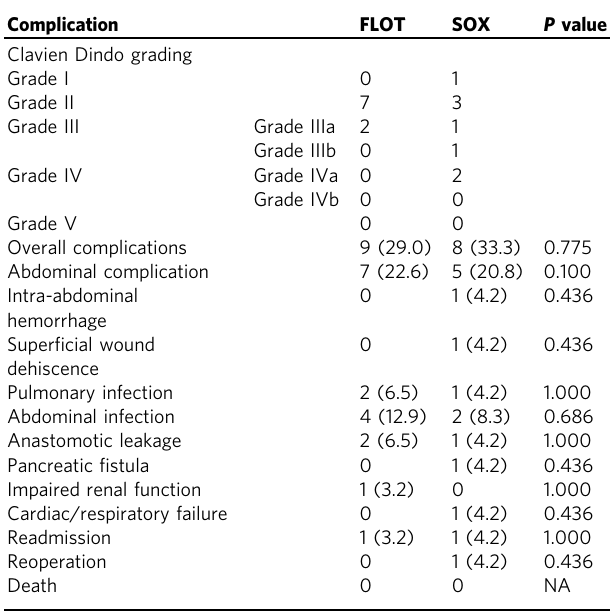
Table 6 Postoperative complications per-protocol (PP) population.